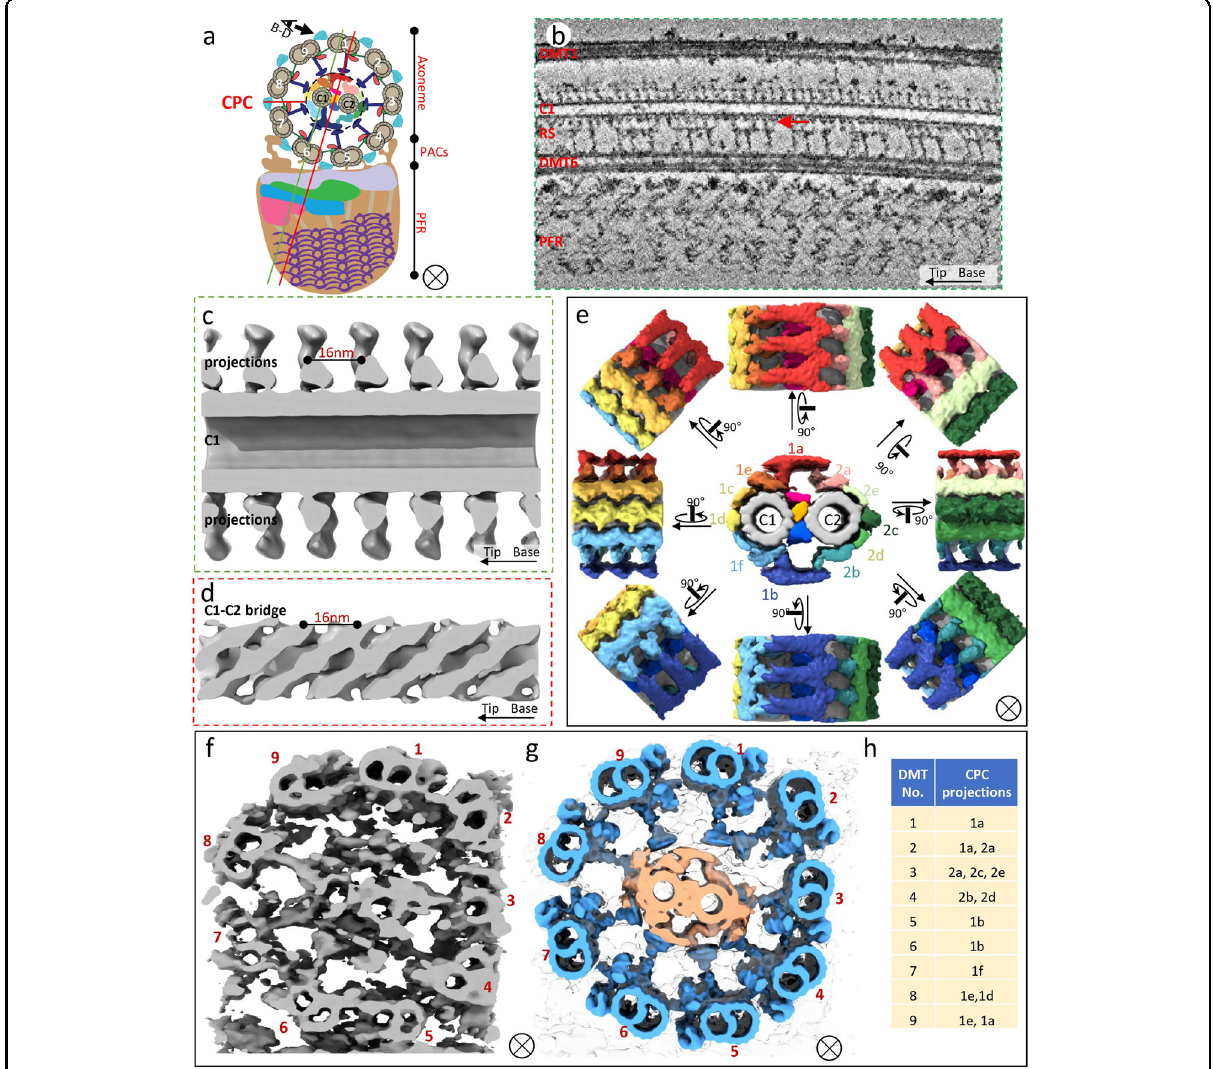
Fig. 6 Structure of the T. brucei central pair complex (CPC). a A schematic illustrating the location and relative orientation of the CPC with respect to the surrounding 9 DMTs. The section planes are indicated for panels b and c (green line), and panel d (red line). b A 10nm-thick density slice through a tomogram along the plane marked by the green line in a . Connections between the RS and CPC are visible (red arrow). c Surface view of the CPC 96 nm sub-tomographic average sectioned along plane marked by the green line in a , showing C1 projections, which repeat at 16 nm intervals. d Surface view of the CPC 96 nm sub-tomographic average sectioned along the plane marked by the red line in a , showing the bridge structure between the C1 and C2 microtubules of CPC, which repeats at 16 nm intervals. e Cross sectional (middle) and rotational (surrounding) surface views of the CPC 16 nm sub-tomographic average, showing the 1a – f and 2a – e projections, C1 and C2 microtubules (gray), and tripartite bridge structure (pink, light orange and blue). f – g Connections between CPC and RS. Surface view of a single tomogram ( f ), fi tting ( g ) of 96 nm averaged CPC and individual DMT-RS structures within the tomogram shown in f . h Summary of contacts observed between CPC and RS from each DMT (based on Fig. 6g; Supplementary Fig.